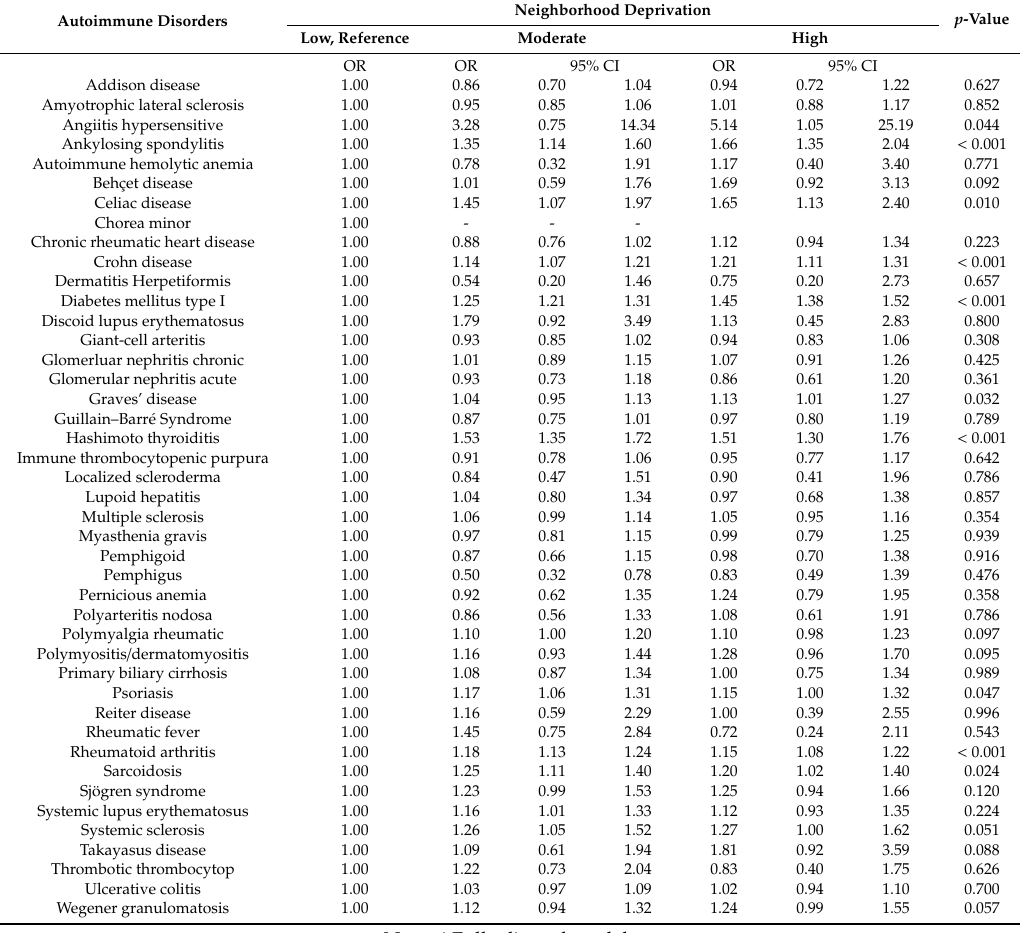
Table 5. Odds ratios (OR) and 95% confidence intervals (CI) for autoimmune disorders *. Neighborhood Deprivation p -Value Autoimmune Disorders Low,